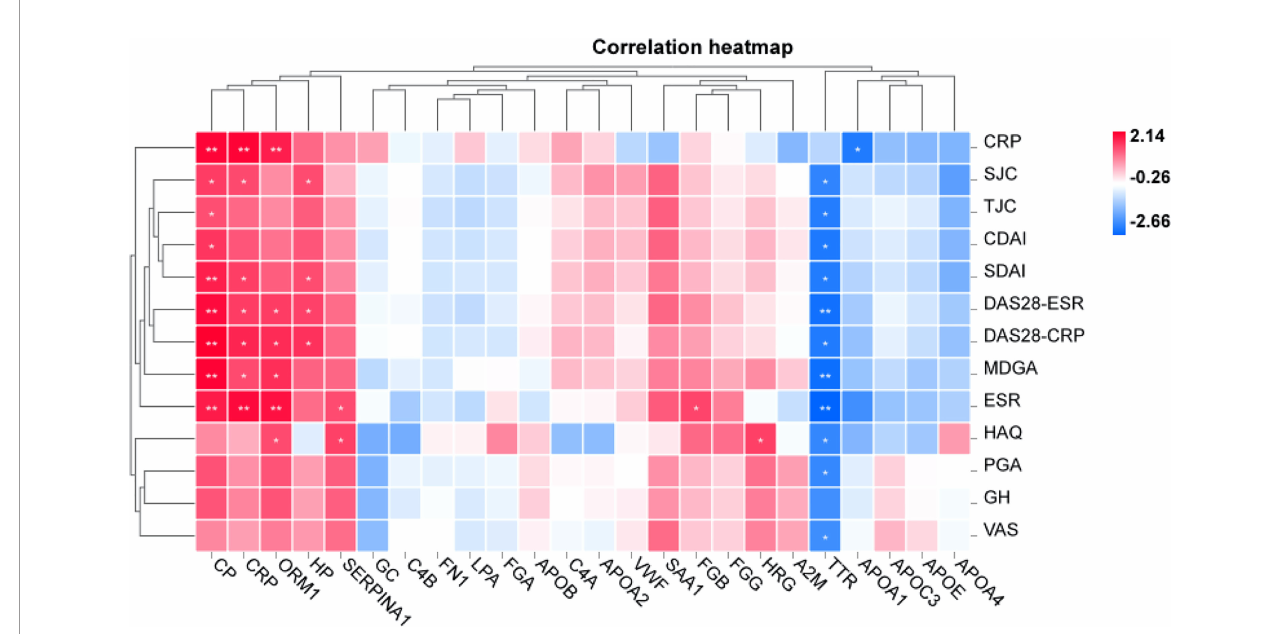
FIGURE 5 | Correlation analysis between RA laboratory diagnostic indicators and disease activity. Positive and negative signs indicate the direction of the correlation. A positive sign indicates a positive correlation (red), and a negative sign indicates a negative correlation (blue). * p < 0.05, ** p <